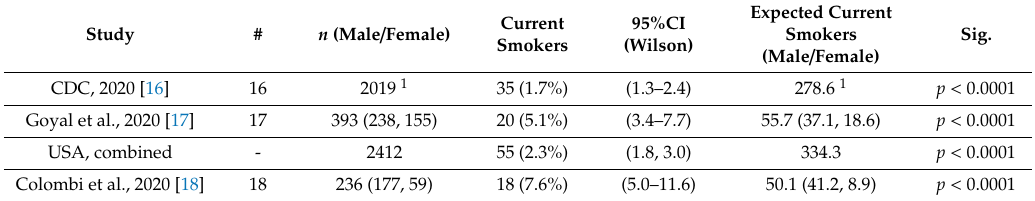
Table 2. Comparison of the hospitalised current smokers in the COVID-19 outbreaks in the USA and Italy. A column with a consecutive number of the studies (#) is included. For each study, the number of male and female hospitalised patients, currently smoking patients, 95%CI calculated with Wilson’s procedure, expected current smokers to be both pooled and by gender (except for study #16), and statistical significance (Sig.; p ) is shown. To calculate the expected current smokers’ values in the USA, 15.6% in males and 12.0% in females were taken, which gave a combined 13.7% [22]. In Italy, 23.3% in males and 15.0% in females were taken [23]. 1 Gender proportions are not